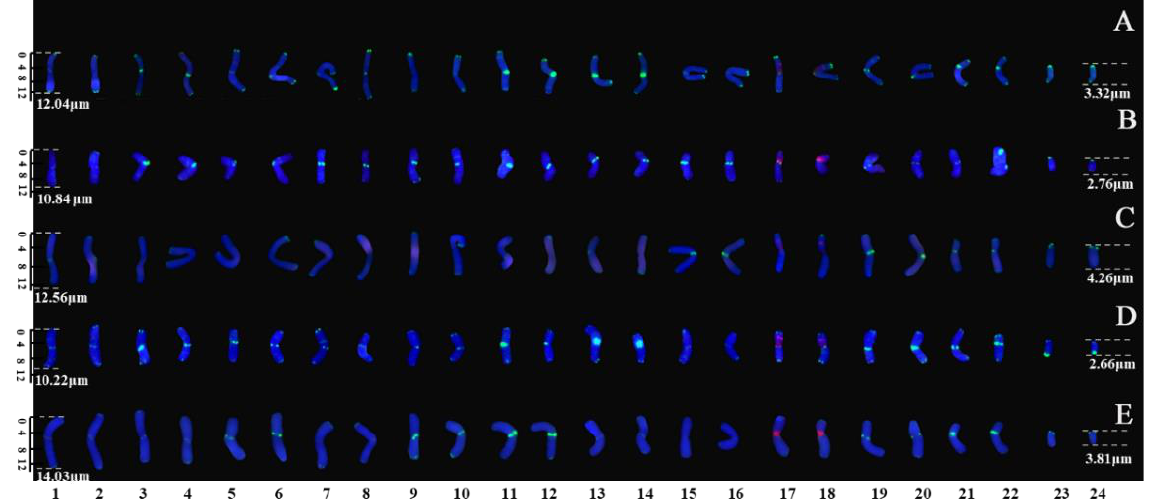
Figure 3. Mitotic chromosomes of five Taxus species rearranged from Figure 1. ( A ) T. wallichiana , ( B ) T. × media , ( C ) T. yunnanensis , ( D ) T. cuspidate, and ( E ) T. wallichiana var. mairei. Each chromosome is numbered according to its length, from the longest to the shortest chromosome. Scale bars range from 1 to 15 μm. Table 2. Karyotype formulas of five species of Taxus . Species Karyotype Karyotype Asymmetry Index